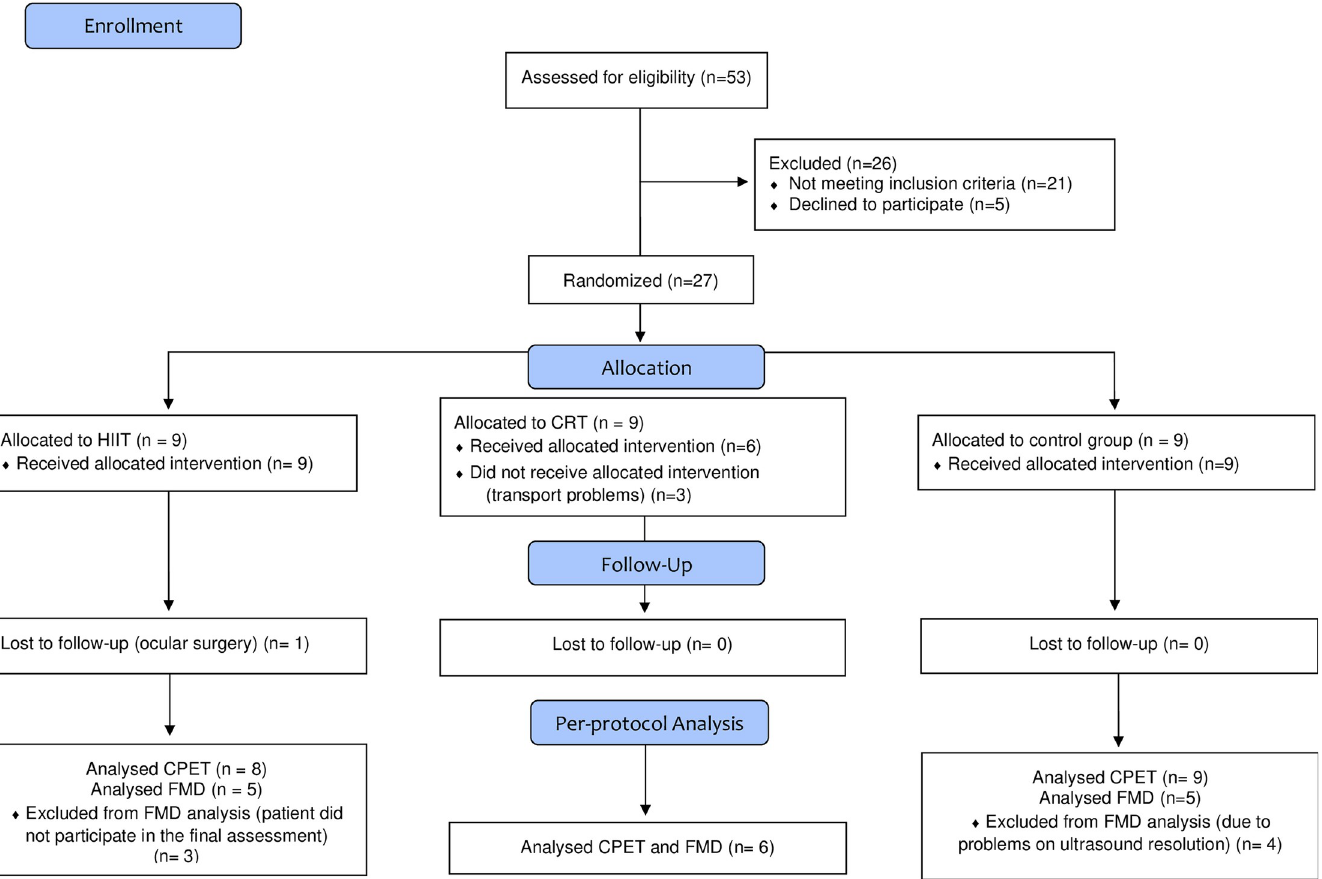
Fig 1. Study flowchart. HIIT, high-intensity interval training; CRT, circuit-resistance training; CPET, cardiopulmonary exercise testing; FMD, flow-mediated dilatation.